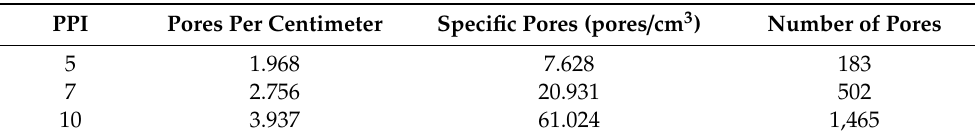
Table 1. Number of pores of foams designed in this work.